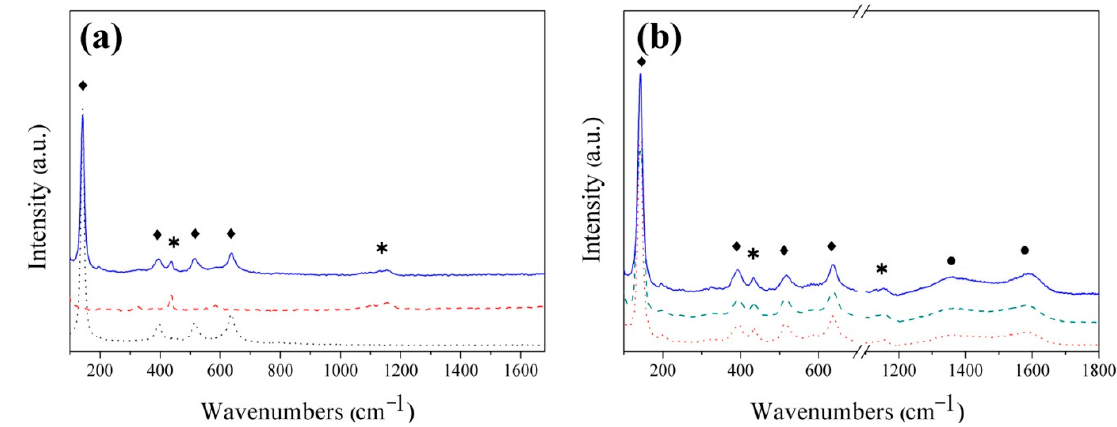
Figure 5. Raman spectra of ( a ) anatase TiO 2 (black dotted line), the wurtzite ZnO flowers (red dashed line), and the ZnO-TiO 2 core-shell flowers (blue solid line) and ( b ) ZT-rGO with 0.5 (red dotted line), 2 (green dashed line), and 5 wt % (blue solid line) rGO (the TiO 2 peaks are indicated with a rhombus, the ZnO peaks with an asterisk and the rGO peaks with a